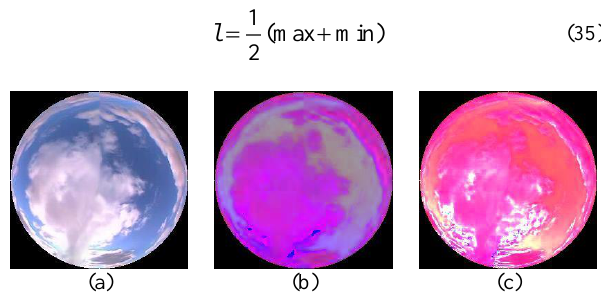
Figure 6. Color feature: (a) RGB color space; (b) HSV